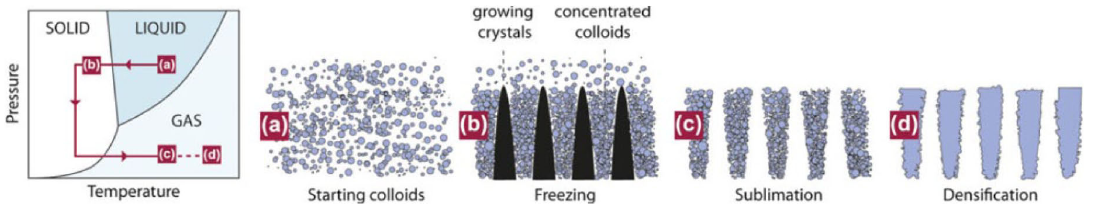
Fig. 12 Schematic diagram of freeze-casting. Reproduced with permission from Ref. [53], © Materials Research Society 2013.